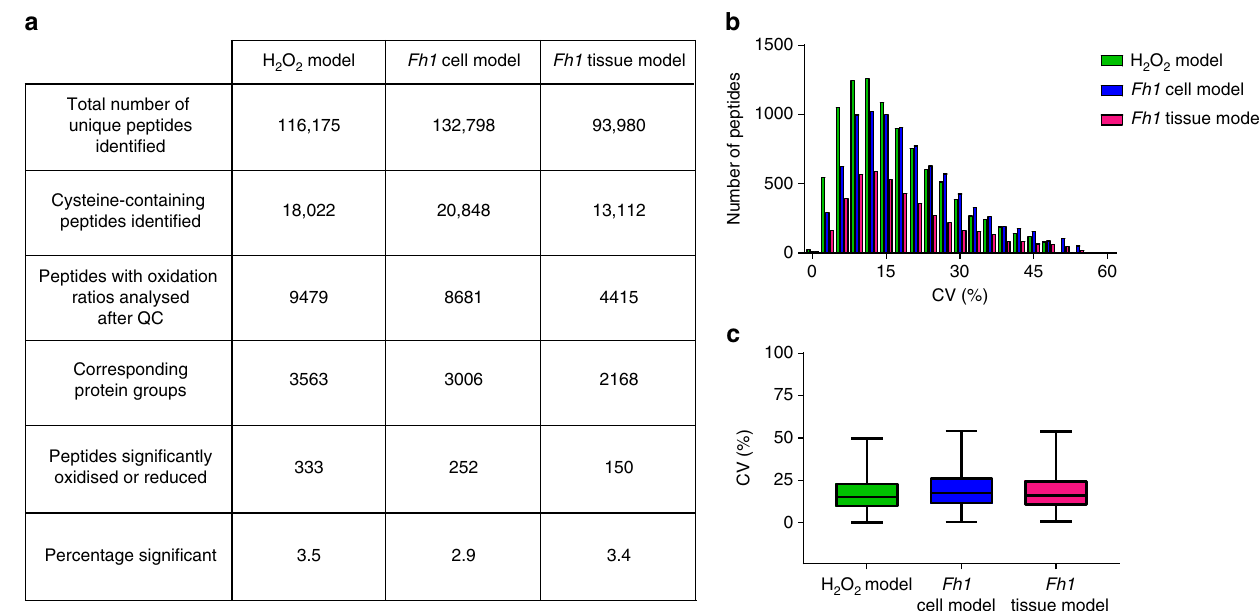
Fig. 2 Performance indicators and reproducibility of the SICyLIA work fl ow. a Number of peptides and proteins identi fi ed using SICyLIA in the three experimental models, broken down into indicated classes. b Histogram distribution and c boxplots of the coef fi cient of variation (CV%) of peptide oxidation ratios between four replicates as identi fi ed using SICyLIA for the three experimental models. Boxplots display 25th and 75th percentile (bounds of box), median (centre line), and largest and smallest value (whiskers) of the distribution. a – c Based on four independent experiments, single measurement (H 2 O 2 model, Fh1 cell model) or the comparison of one mouse per genotype, using four replicate tissue slices per mouse ( Fh1 tissue